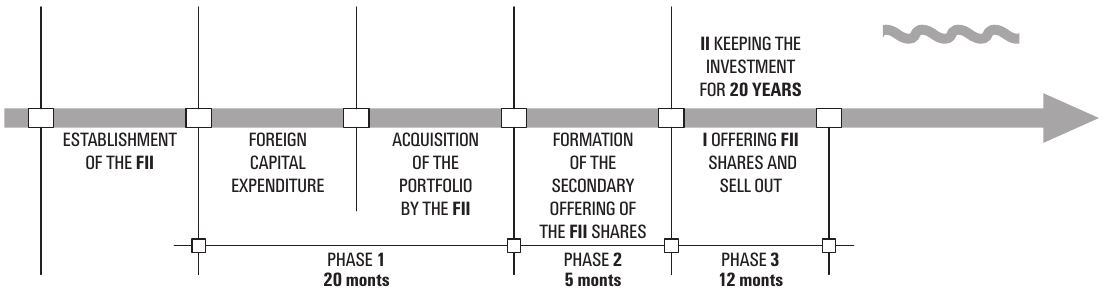
Figure 1. Investment movements, entering the FII and exit strategies I and II